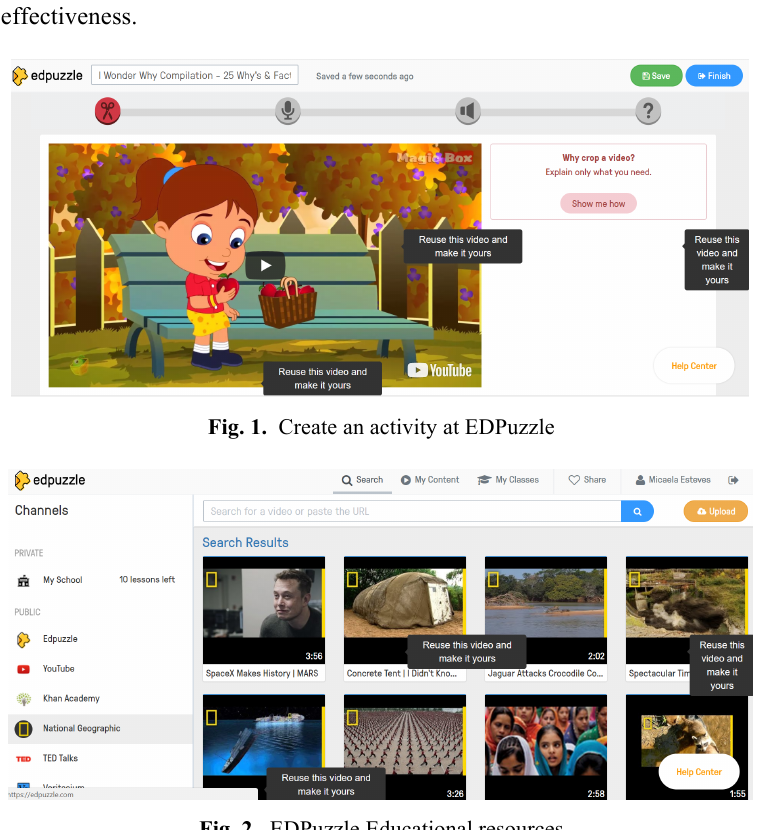
Fig. 2. EDPuzzle Educational